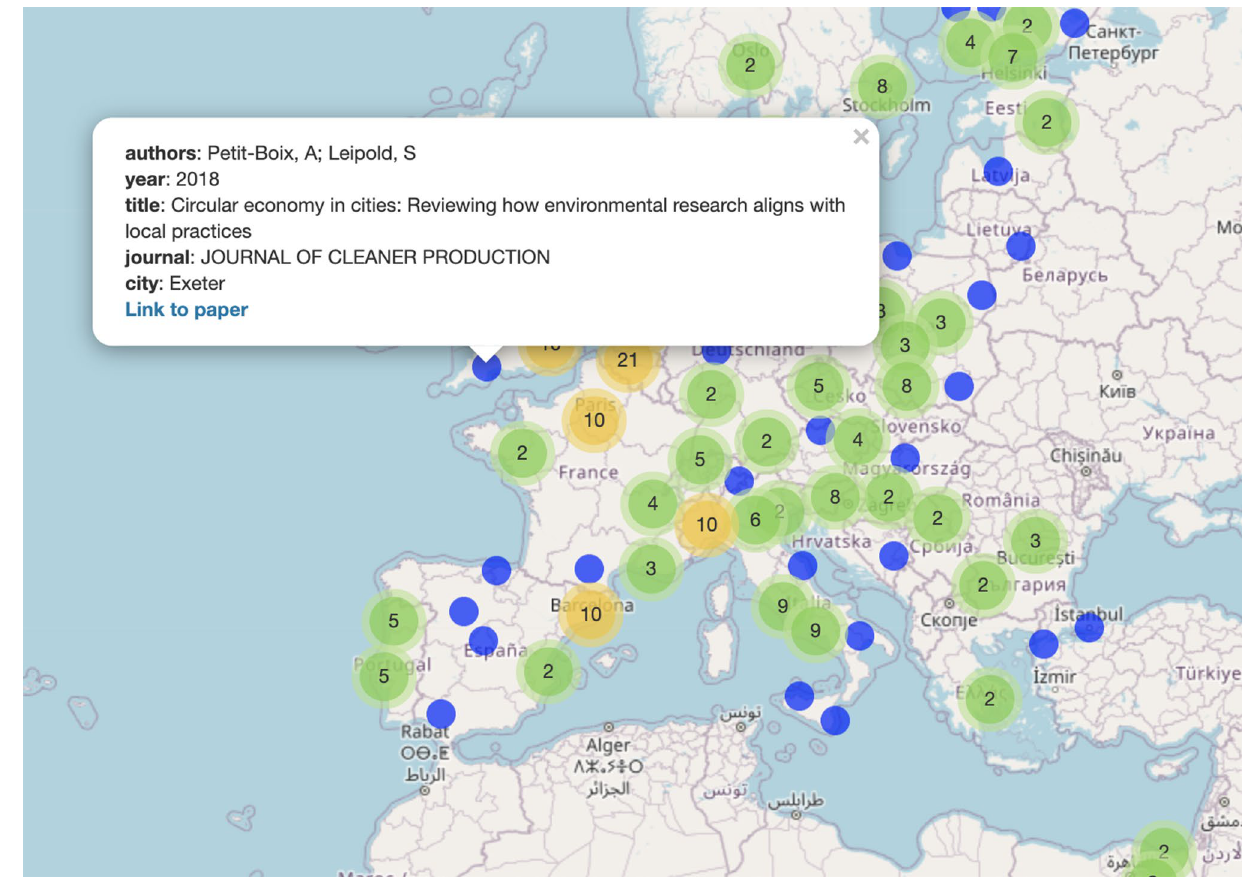
Fig. 2 Snapshot of the interactive evidence atlas available at (own website—to be added)